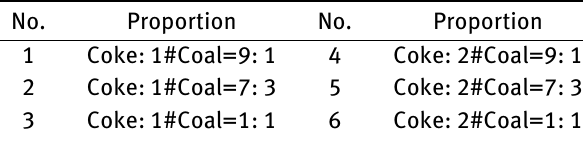
Table 2: Proportion scheme of experimental sample No. Proportion